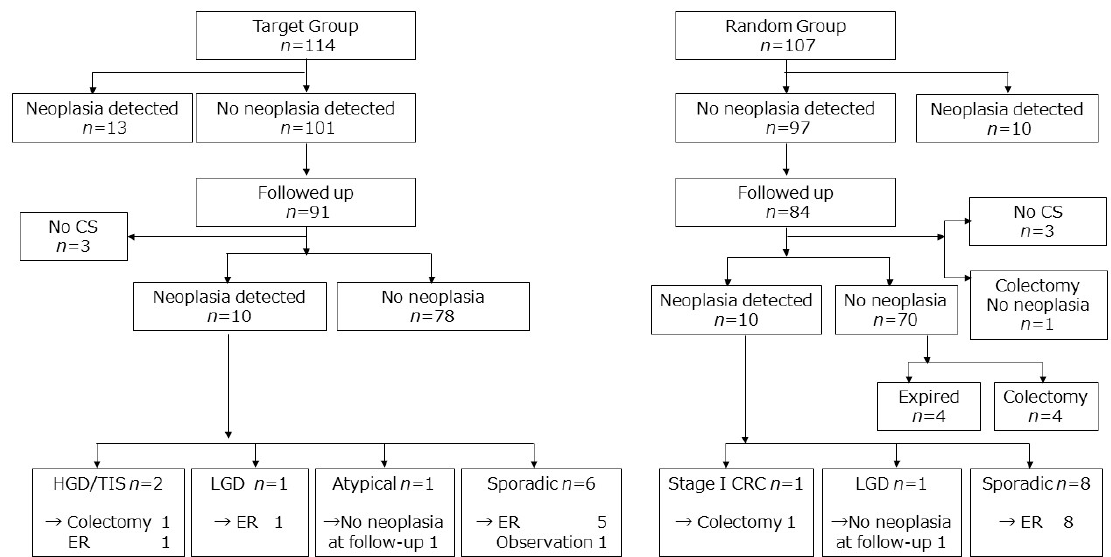
Figure 1. Follow-up results of patients without neoplasia during the randomized controlled study. Only one patient from the random group developed invasive colorectal cancer. Abbreviation: CRC, colorectal cancer; CS, colonoscopy; ER, endoscopic removal; HGD, high-grade dysplasia; LGD, low-grade dysplasia; TIS, tumor in situ.